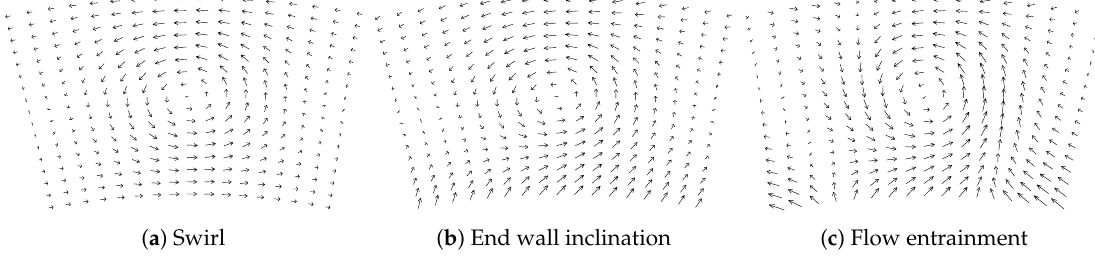
Figure 2. Generation of the in-plane velocity